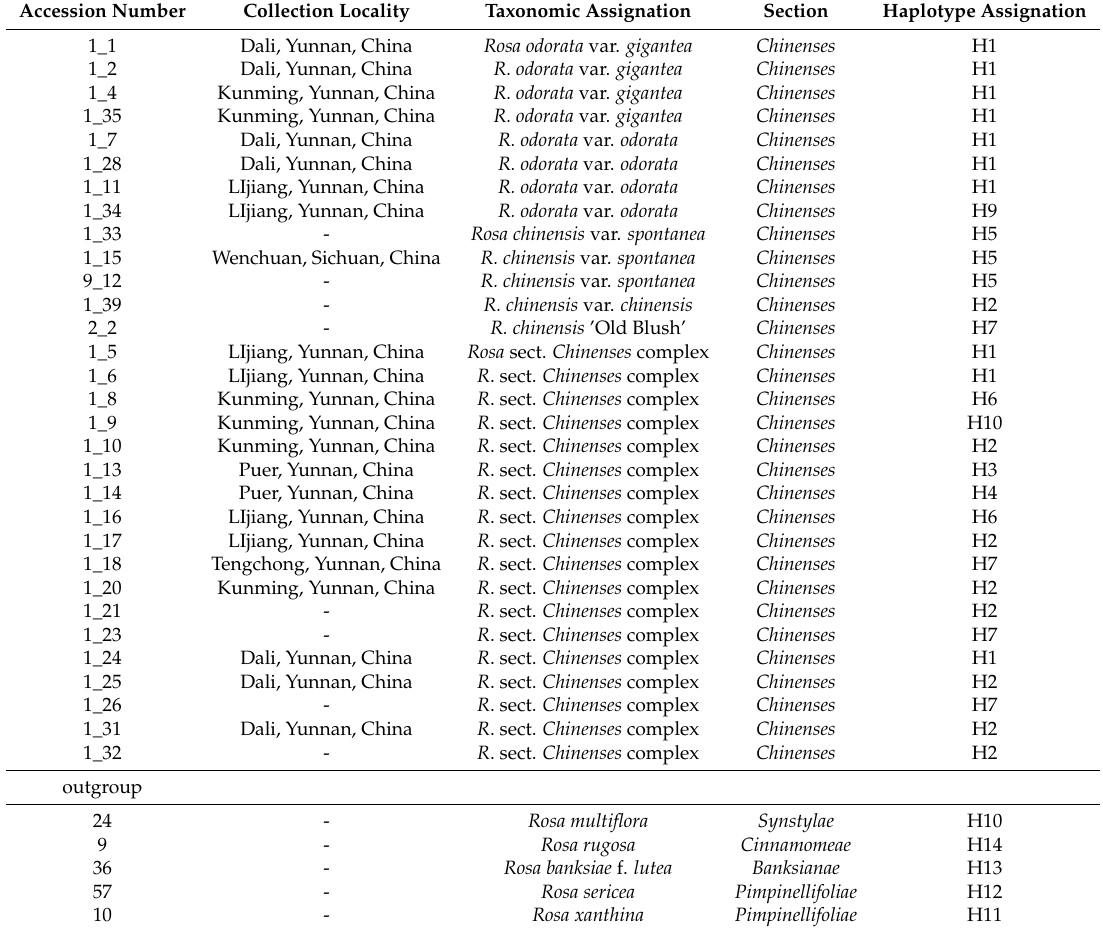
Table 1. Classification of rose